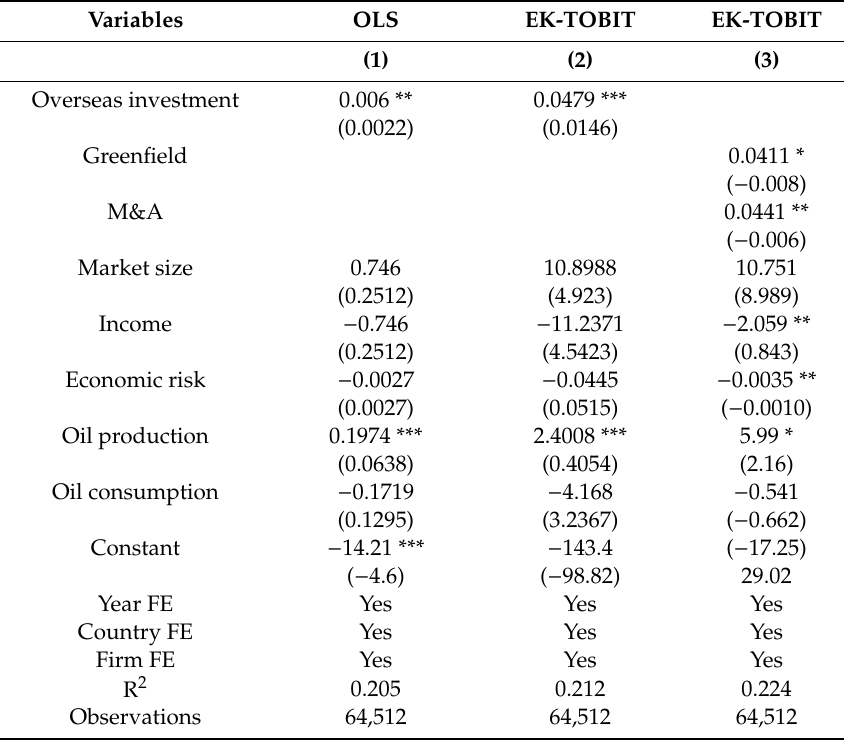
Table 3. Estimation results for oil import volume (Equation